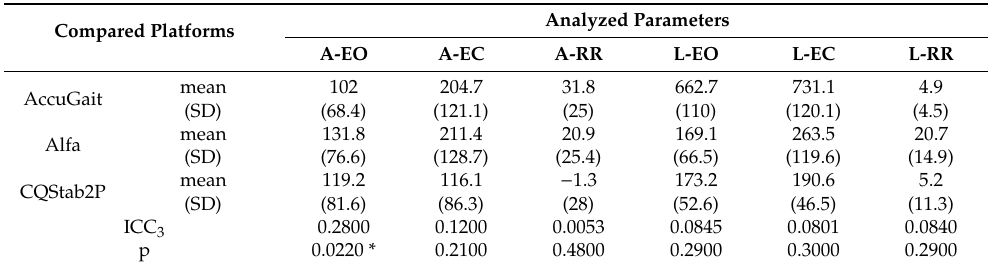
Table 1. Two-way mixed intraclass correlation coe ffi cients for measures for the compared platforms for all analyzed